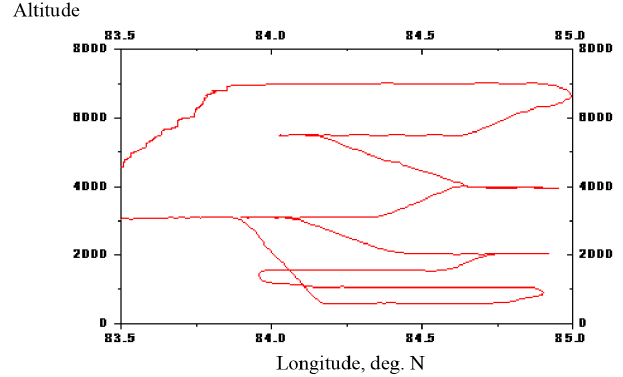
Figure 4. Altitude profile of the flight of the Tu-134 OPTIK flying laboratory on 9 April 2013.